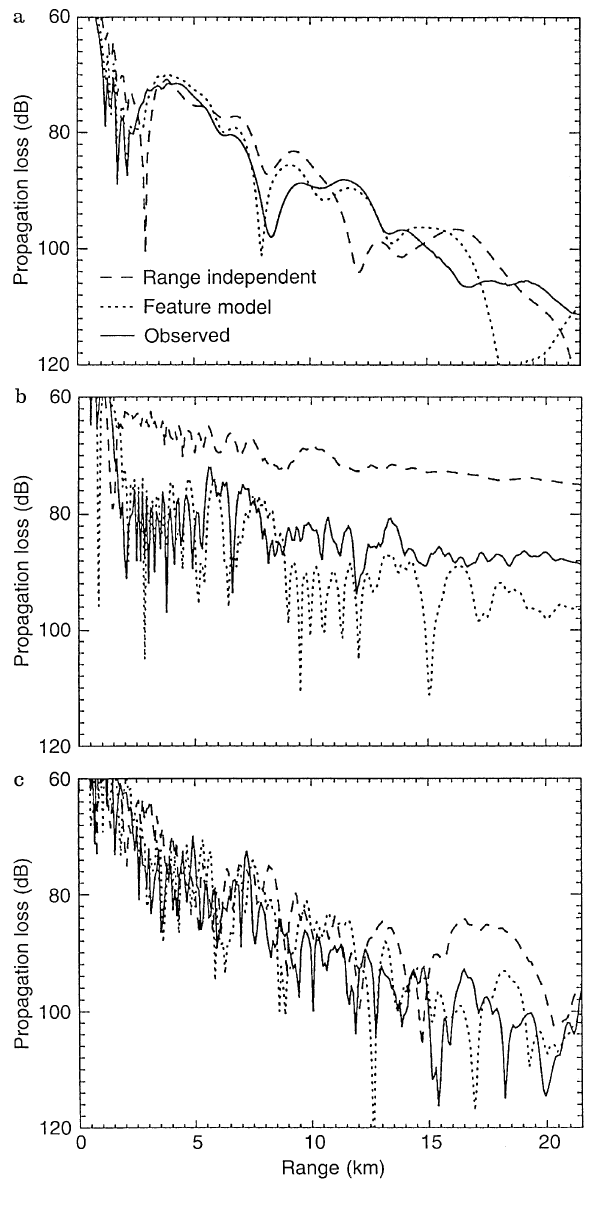
Fig. 9a (cid:177) c. Propagation-loss values obtained through the eddy environment: a frequency 50 Hz, source and receiver depth 50 m; b frequency 400 Hz, source and receiver depth 50 m; c frequency 400 Hz, source depth 50 m and receiver depth 150